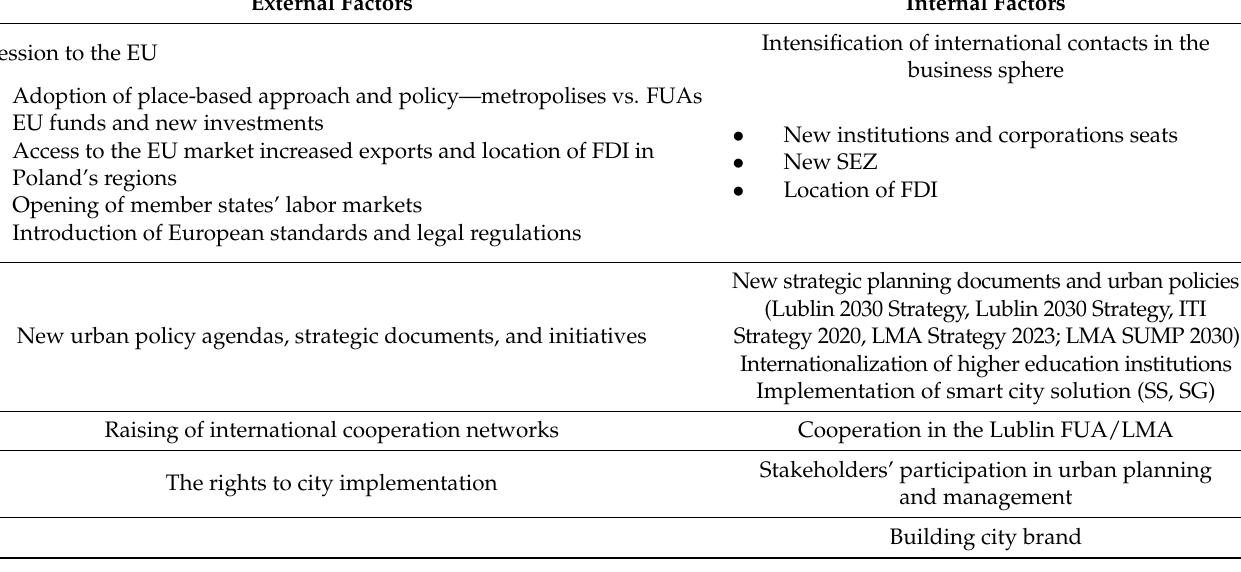
Table 3. External and internal factors of Lublin development support for the Smart City